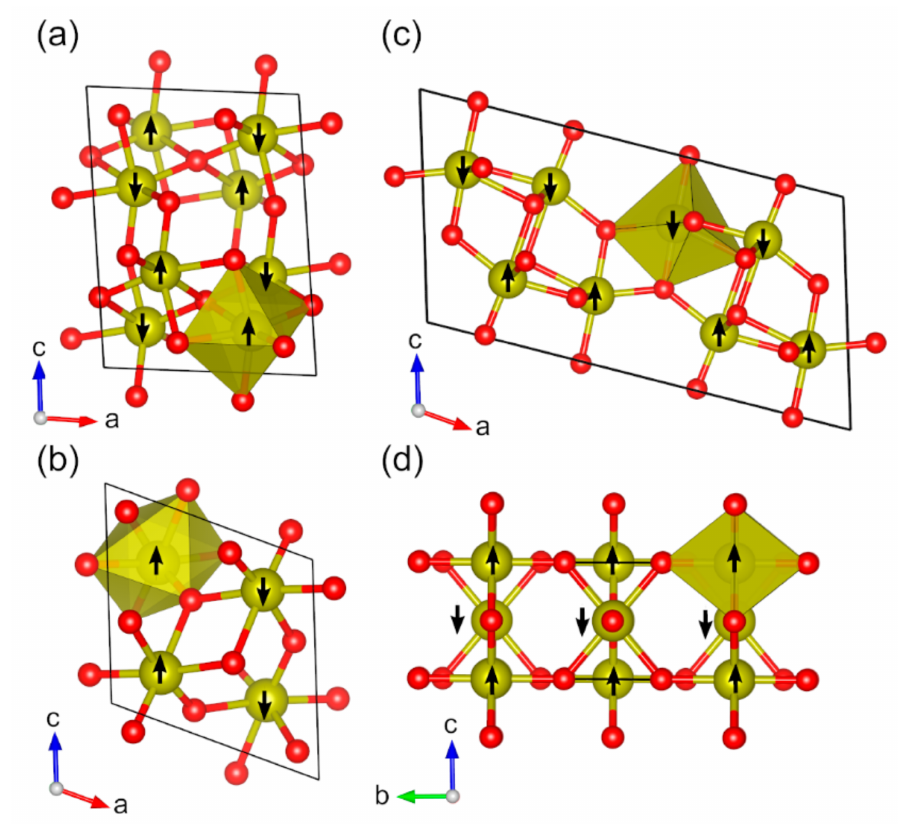
Figure 3. Optimized structures of studied magnetic binary vanadium oxides (red: O, yellow: V): ments are illustrated by black arrows. Coordination octahedra of V atoms are shown in yellow